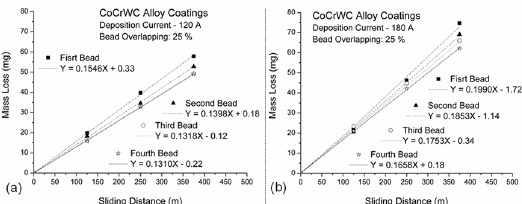
Figure 12. Mass loss versus distance for 25 % overlapping: (a) 120 A and (b) 180 A.